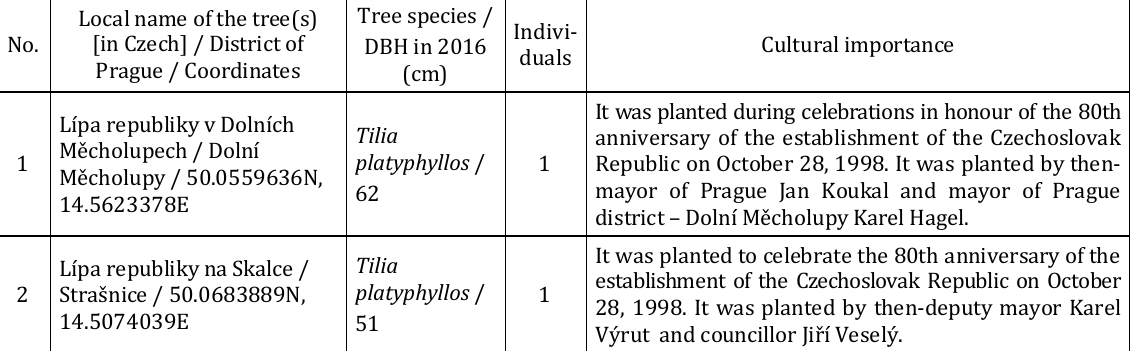
Table 1. Culturally significant young trees (CSYTs) in the study area of